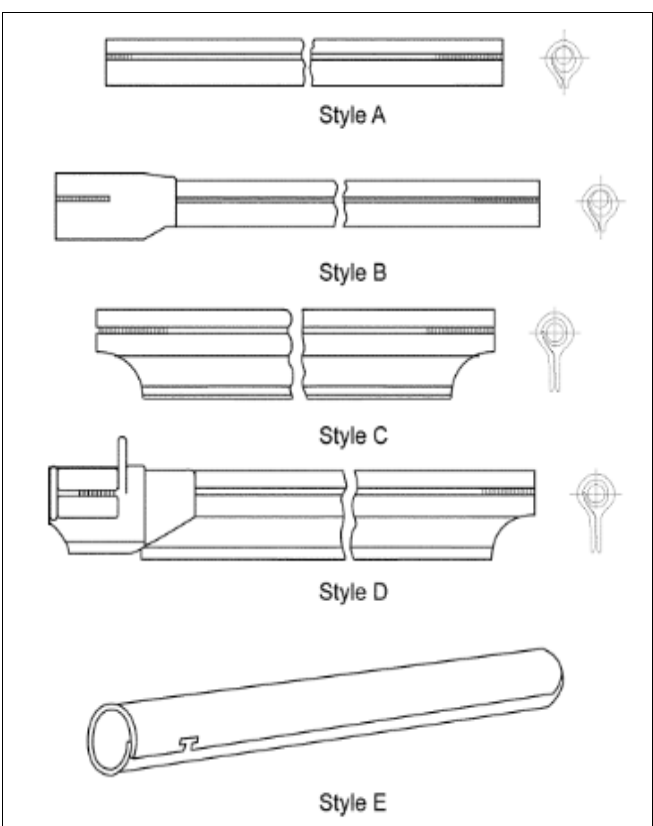
Figure 2: Different styles of flexible conductor covers. Source: